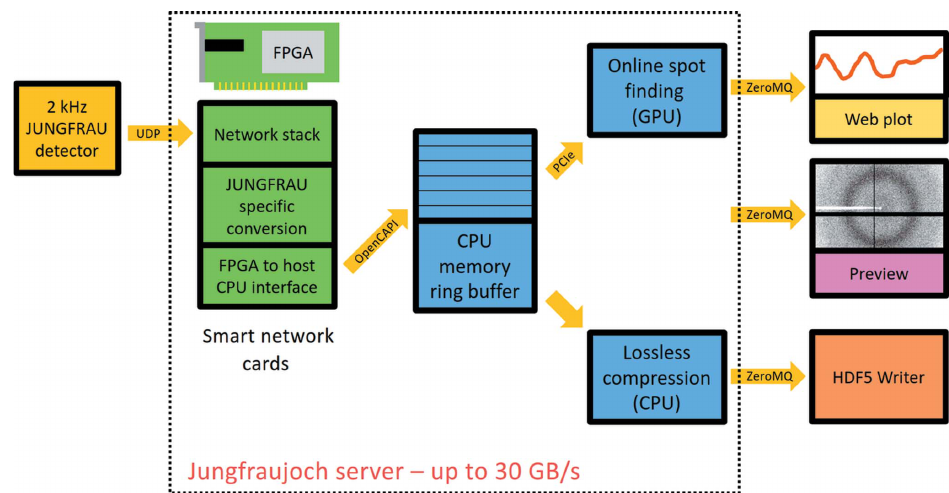
Figure 2 The Jungfraujoch data flow from the JUNGFRAU detector, via the FPGA card to the CPU buffer for compression and spot finding.